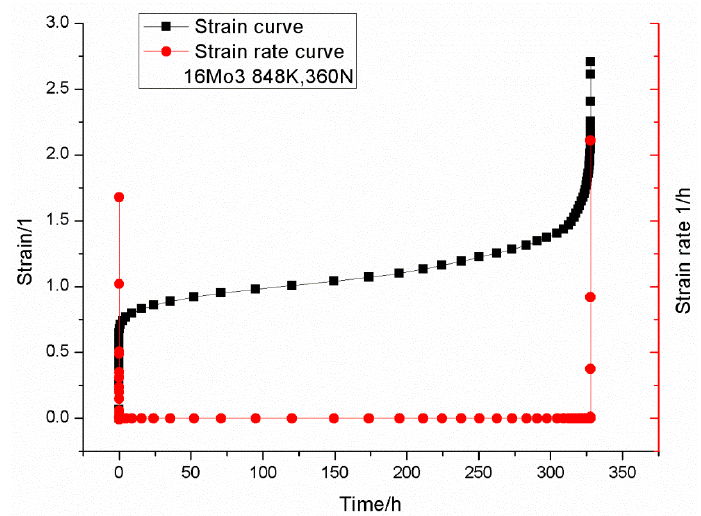
Figure 4. The time–strain versus strain rate curve of 16Mo3 at a testing condition of 848 K, 360 N.